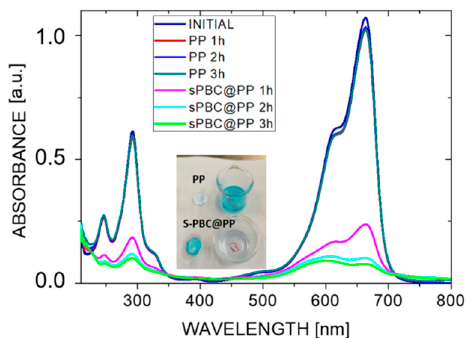
Figure 3. UV–Visible absorbance spectra of methylene blue (MB) solutions after dipping PP and s-PBC@PP for 1, 2, or 3 h. In the inset, a photo of the filters and dyes solutions after three hours of adsorption.